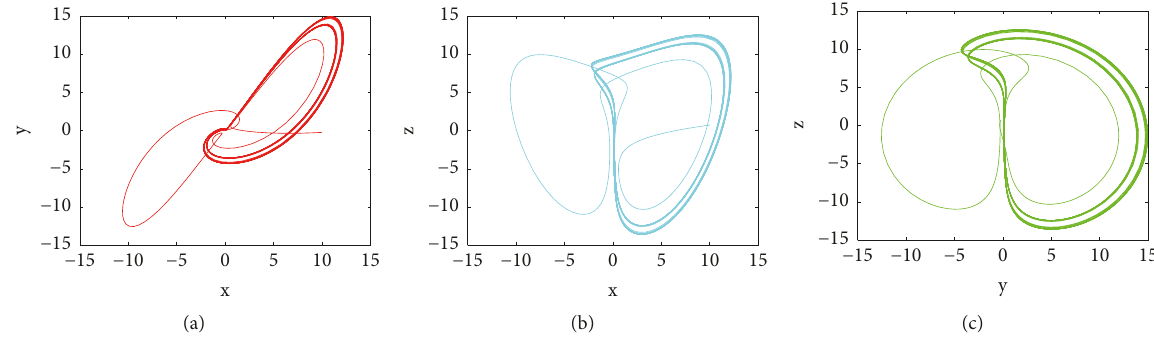
Figure 8: Phase portraits of the 3D chaotic Lorenz type system for Experiment 3 at 𝑐 = 1 : (a) (𝑥,𝑦) -plane; (b) (𝑥,𝑧) -plane; (c) (𝑦, 𝑧) -plane.